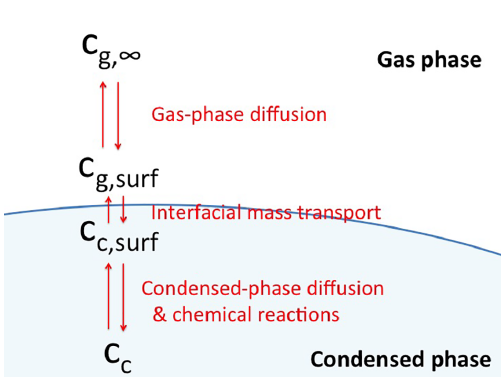
Figure C1. Processes involved in the equilibrium between the gas phase and condensed phase, where c g , ∞ is the gas-phase concentra- tion in the snow interstitial air far away from the droplet, c g , surf is the gas-phase concentration at the surface (outside the droplet), c c , surf is the condensed-phase concentration at the surface (inside the droplet) and c c is the average condensed-phase